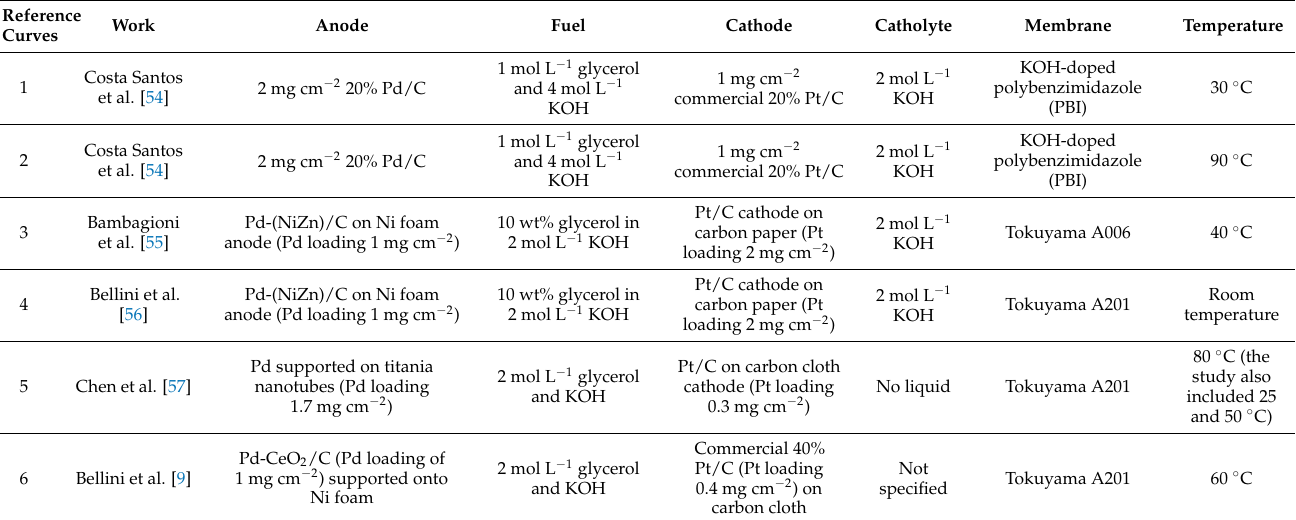
Figure 4. ( a ) Power vs. H 2 flux of the glycerol alkaline-acid electrochemical reformer in the sponta- neous region, and ( b ) Energy demand for the electrolysis mode region including comparison with other studies presented in the literature (see Table 2 for details about each entry). Table 2. Information about the studies used for comparison purposes in Figure 4